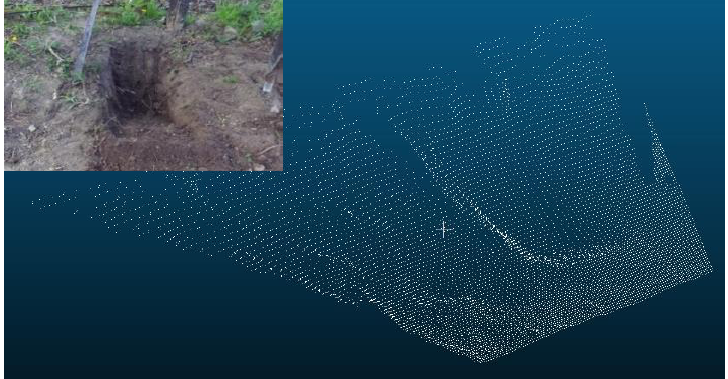
Figure 15. Point cloud of the ground surface before excavation.